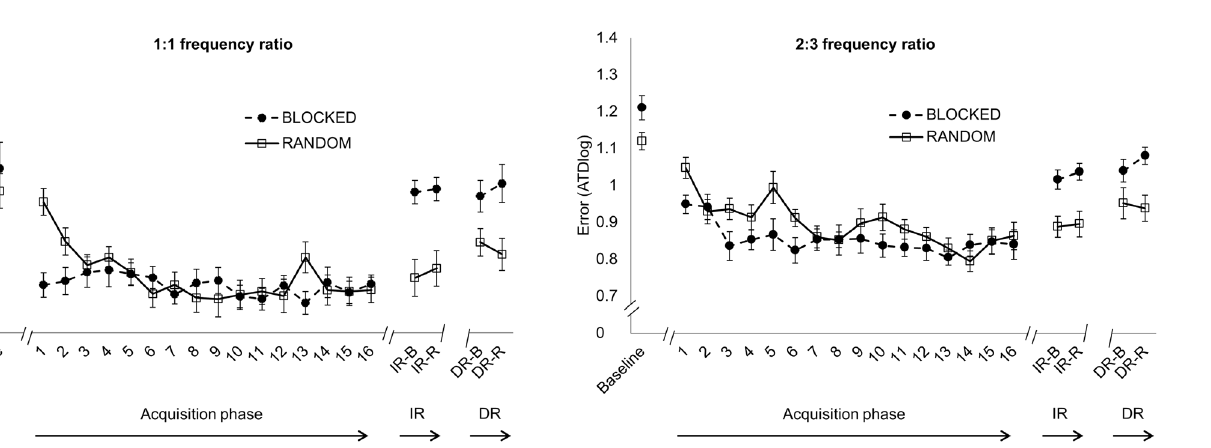
Figure 4. 1:1 frequency ratio. Error score (ATDlog, i.e. the log- transformed average target deviation) for baseline, acquisition phase (TR1-16), immediate retention (IR) and delayed retention (DR) (mean 6 standard error) learned under either a blocked (black circles) or randomized (white squares) practice schedule. Better performance is indicated with lower levels of ATDlog.